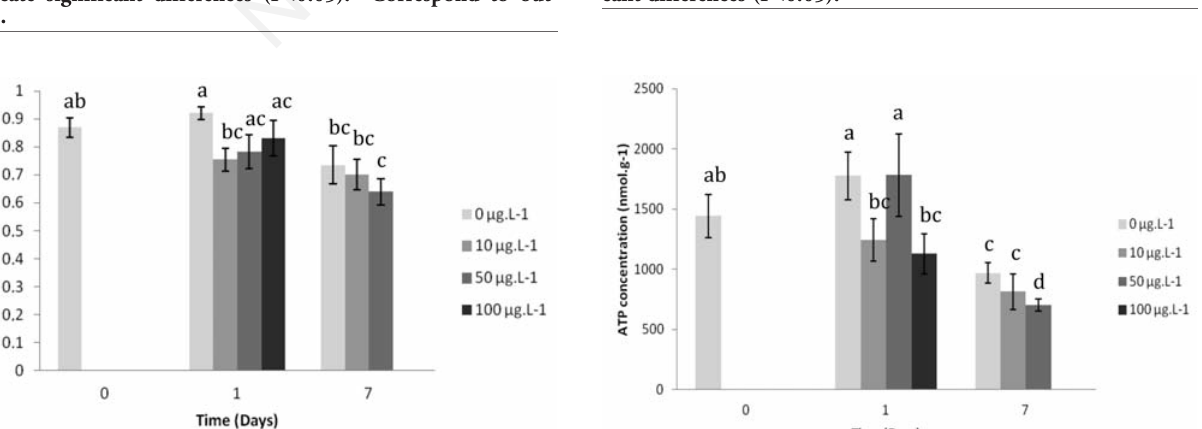
Figure 2. Electron transport system activity during copper expo- sure in white muscle of roach. Different letters indicate signifi- cant differences (P<0.05).